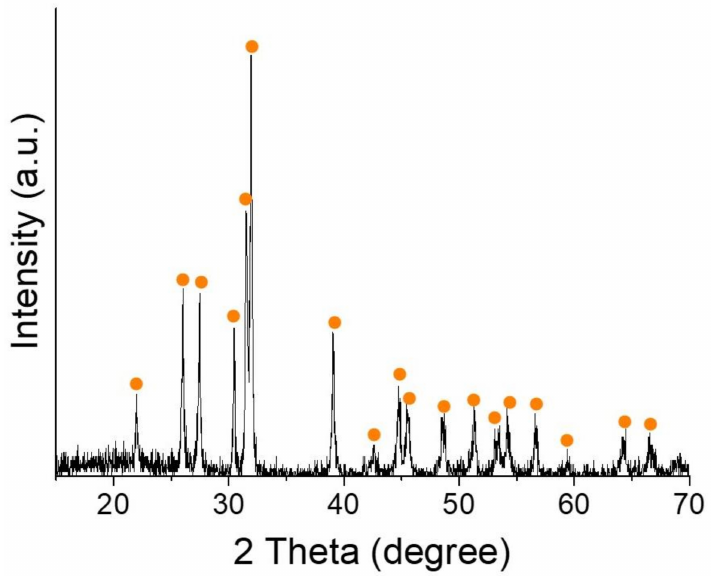
Figure 2. XRD result of the F-SnS NPs synthesized in this study. The dots indicate peaks associated with the SnS crystalline phase (herzenbergite, JCDPS 01-073-1859).